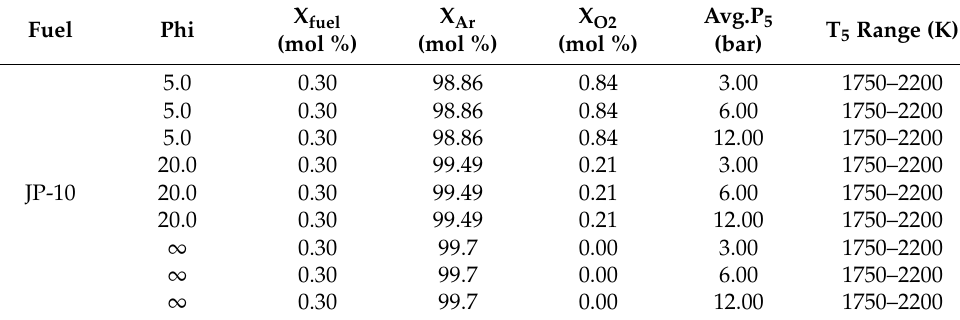
Table 4. Soot-related experimental conditions in this